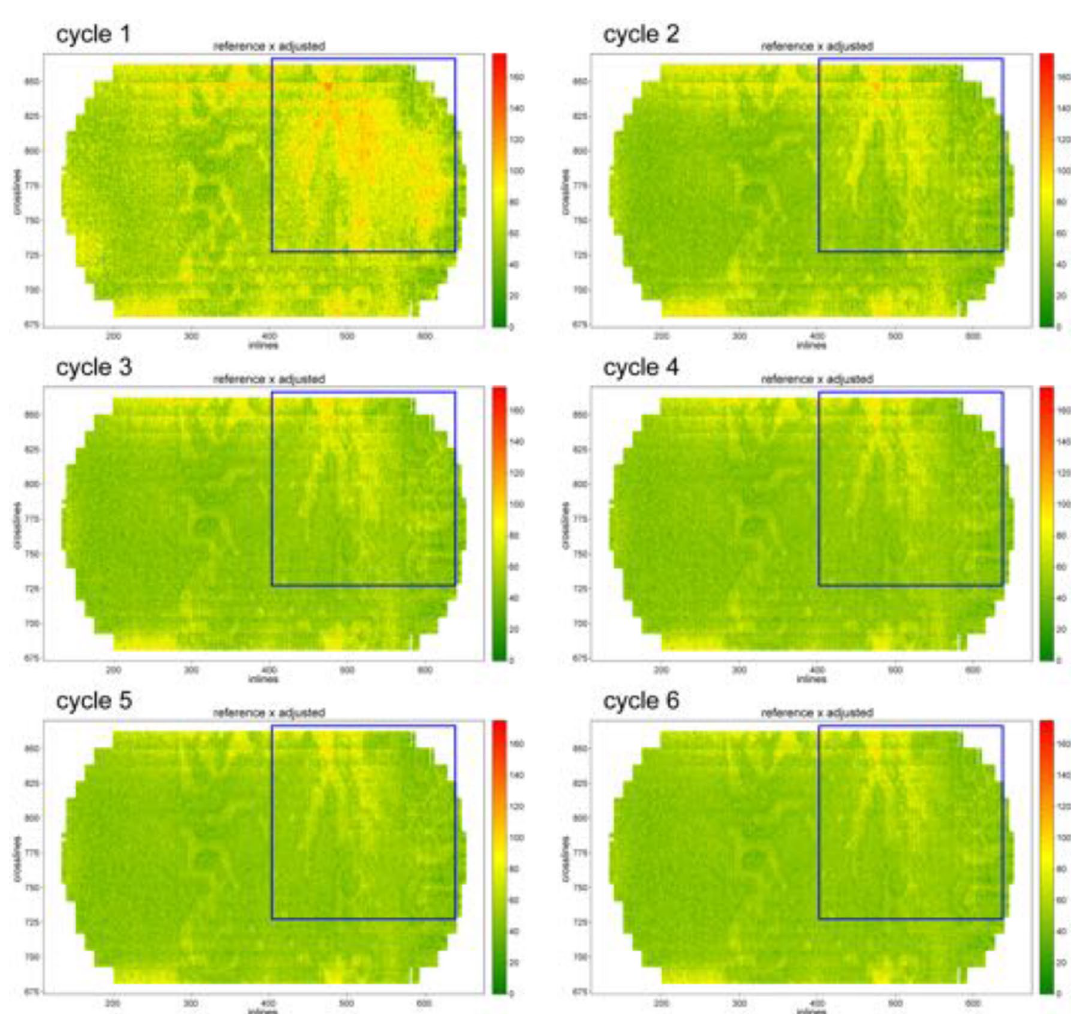
Figure 6. Evolution of the difference score for the gathers of DS2 with a colormap: the greener, the better. The horizontal axis represents the inlines, and the vertical, the crosslines. The blue box highlights a region where the results were considerably